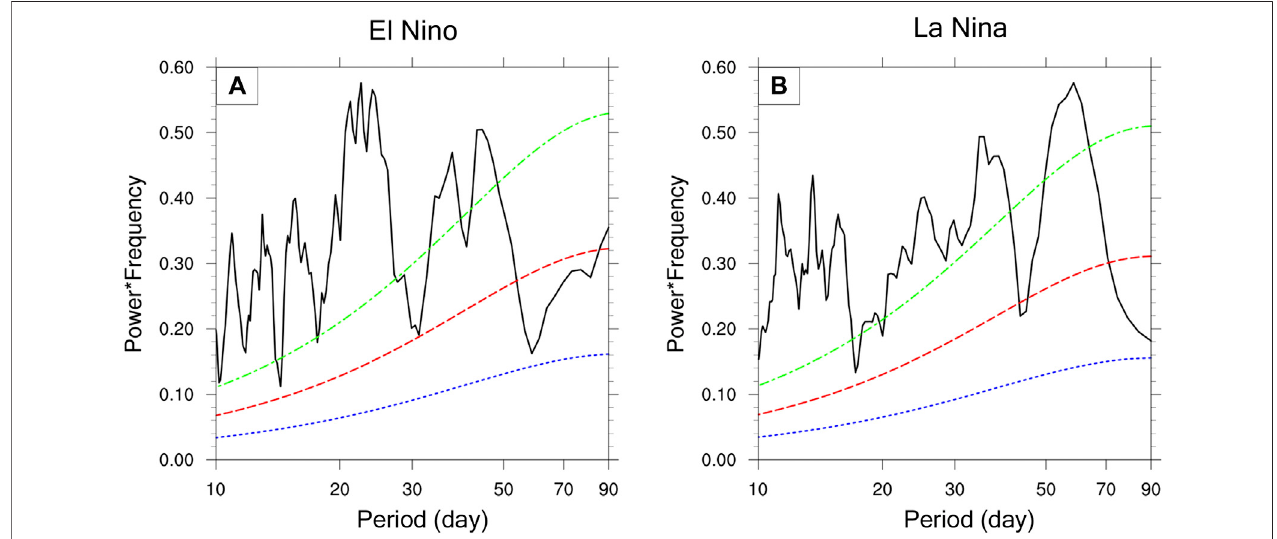
FIGURE 4 | Same as Figure 1 but for the power spectrum of the EAP index during El Niño (A) and La Niña (B) summers.